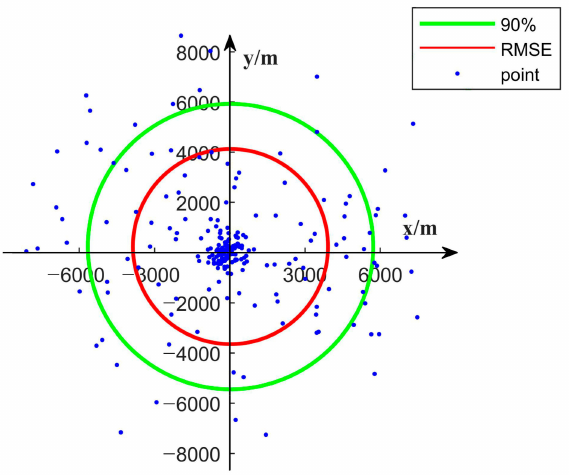
Figure 5. External geometric accuracies of selected GF-4